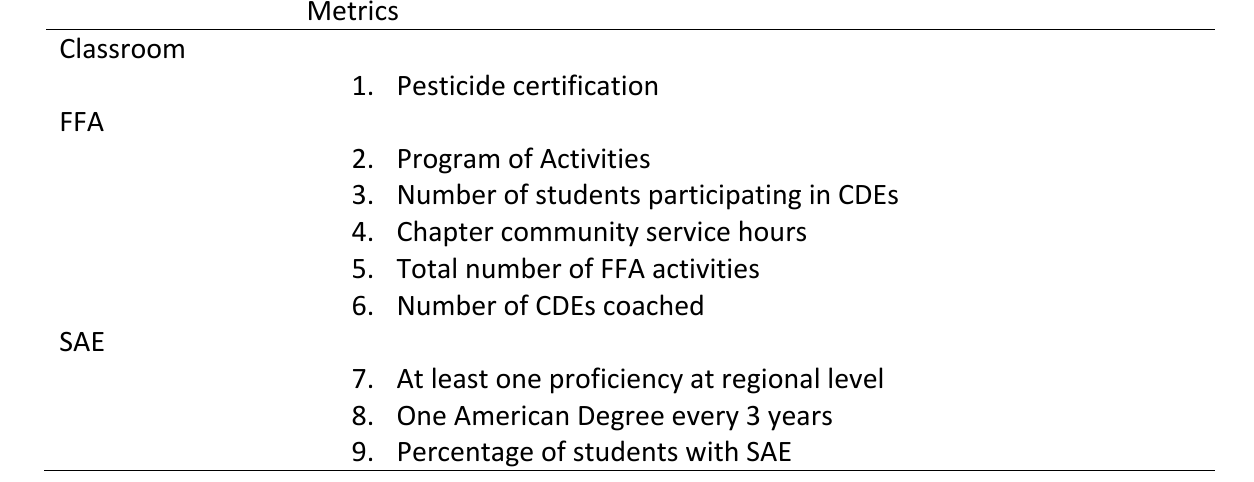
Metrics Retained as Indicators of Excellent Agricultural Education Total